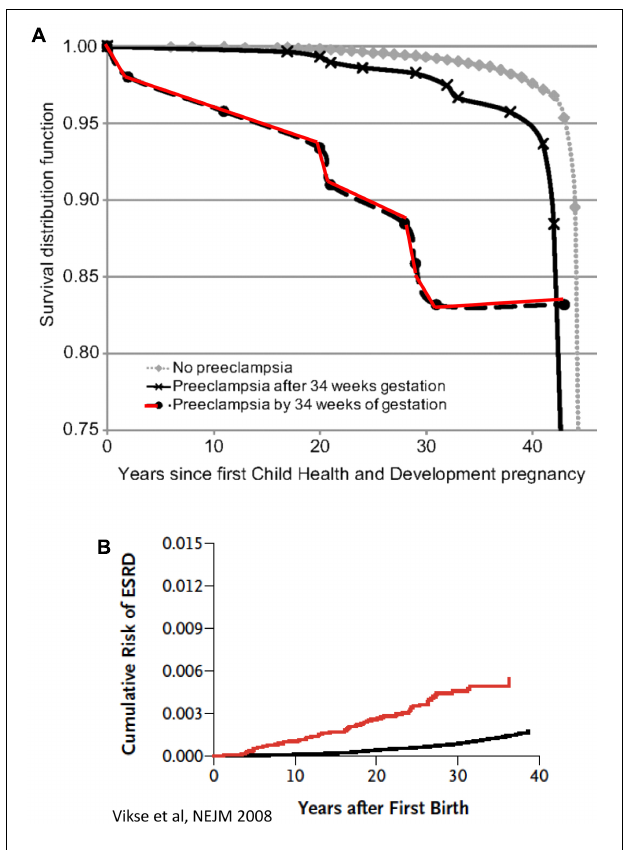
FIGURE 1 | (A) CVD death Kaplan–Meier survival according to gestational timing of preeclampsia. Survival analysis is based on 14, 403 pregnant women. A total of 481 had observed preeclampsia, and 266 died from cardiovascular disease (adopted with permission from Mongraw-Chaffin et al., 2010). (B) Cumulative risk of end-stage renal disease (ESRD) after first preeclampsia (adopted with permission from Vikse et al.,